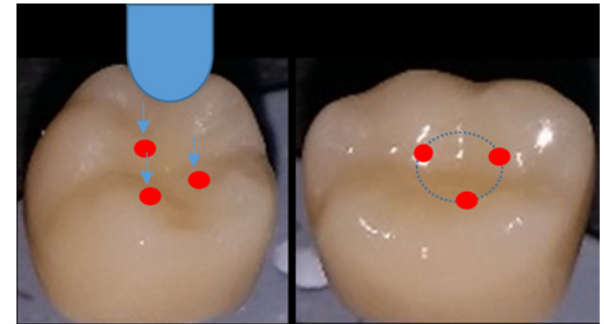
Figure 2. Diagram of teeth preparation.